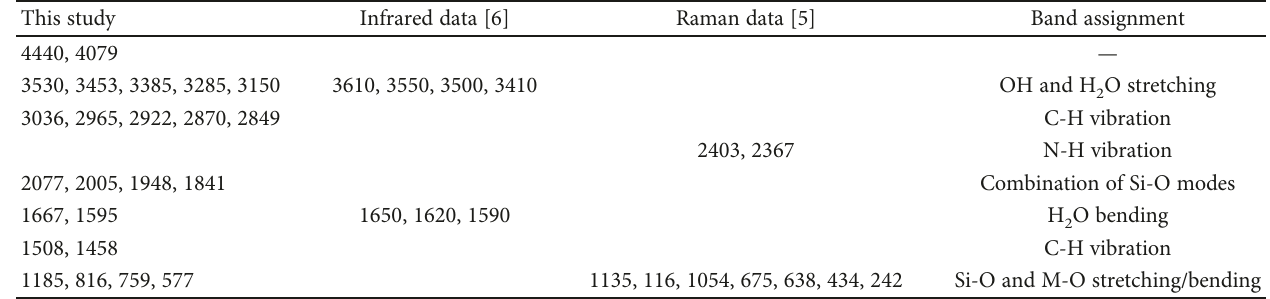
Figure 3: Decomposition of the hydrogen stretching modes region for the unheated charoite. Table 1: Band position (cm − 1 ) and assignment for the bands in the infrared spectrum of the studied (see Figures 1 and 3) and literature